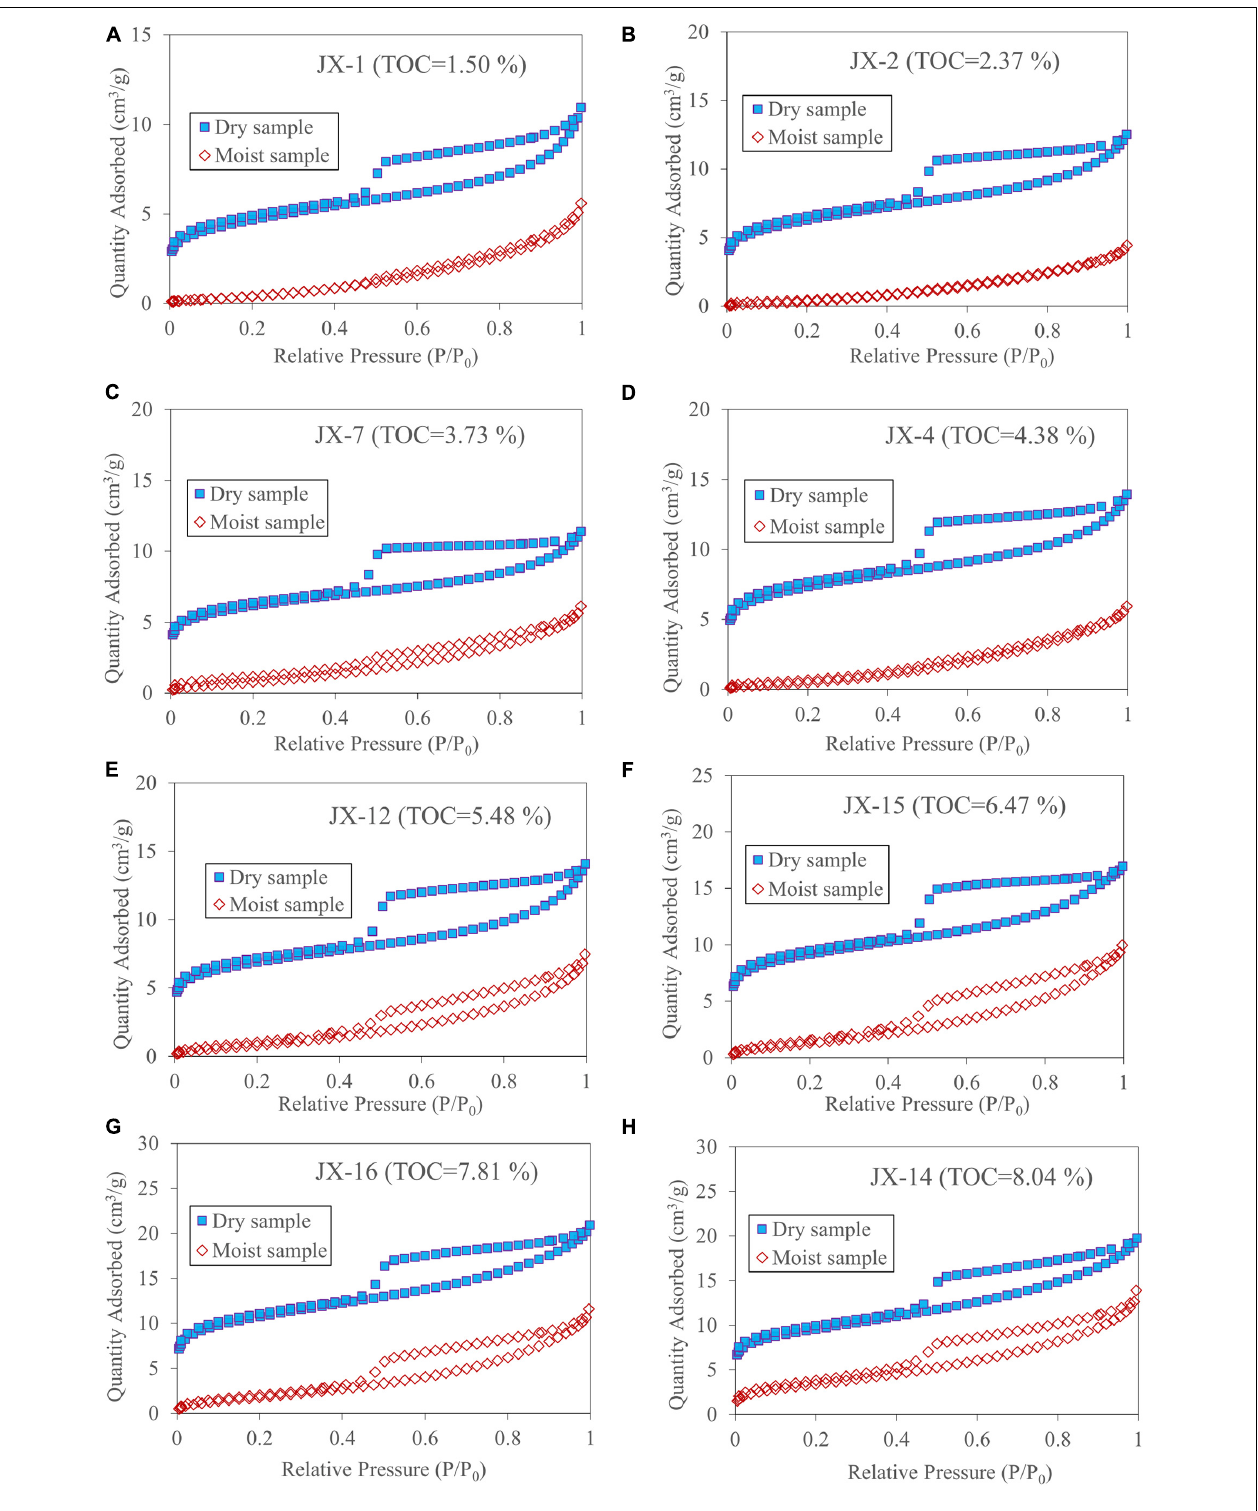
FIGURE 2 | Plots displaying a comparison of the low-pressure N 2 adsorption and desorption isotherms of the selected 8 pairs (moist and dry) shale samples with different TOC contents (A–H) . The difference between the moist and dry samples indicates that water influences the N 2 adsorption capacity and pore structure. Besides, the N 2 adsorption quantities of different samples are likely related to their TOC contents, which will be discussed in see section “Controlling Factors of the Shale Pore Structure.”